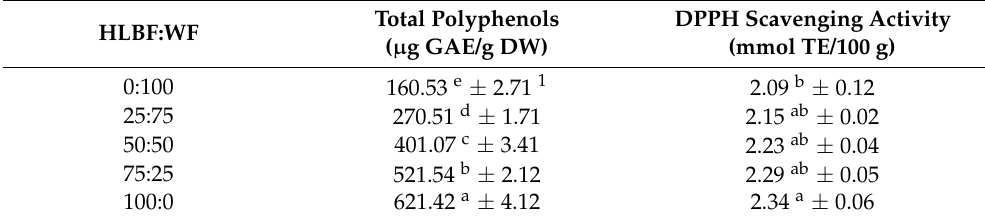
Table 5. Total phenolic content (TPC) and antioxidant capacity (AOC) of cookies made from composite flours containing wheat flour (WF) and hulless barley flour